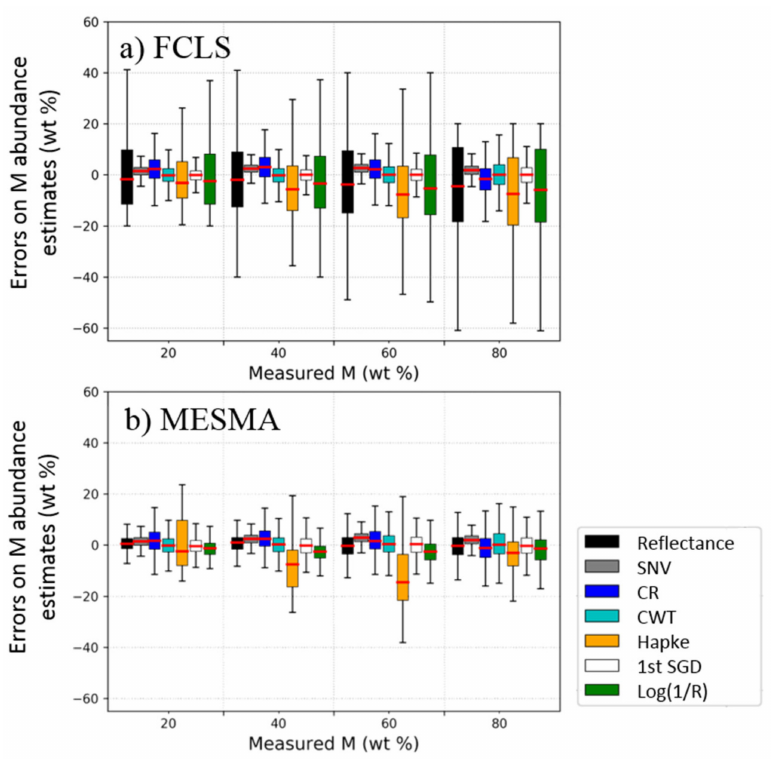
Figure 9. Performances of montmorillonite abundance estimation in illite–montmorillonite aeral mixtures with the ( a ) fully constrained least square method (FCLS) and ( b ) multiple endmember spectral mixture analysis (MESMA) unmixing method. Table 4. Performances of linear unmixing methods to estimate montmorillonite abundances for illite–montmorillonite (IM) and montmorillonite–kaolinite (MK) aeral and intimate mixtures with di ff erent combinations of spectral preprocessings (best results in grey cells with bold font).